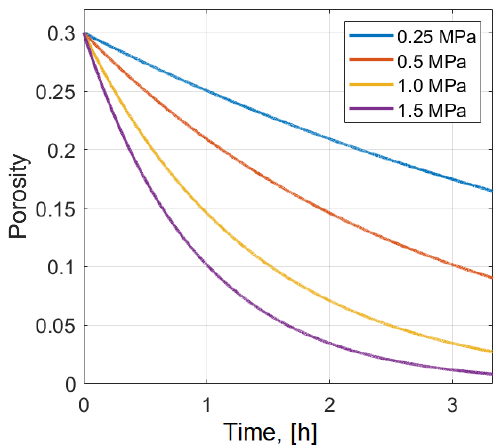
Figure 14. Dependence of the porosity on time at different values of the sintering stress. The initial porosity value is 0.3, η = 0.5 × 10 10 Pa ·